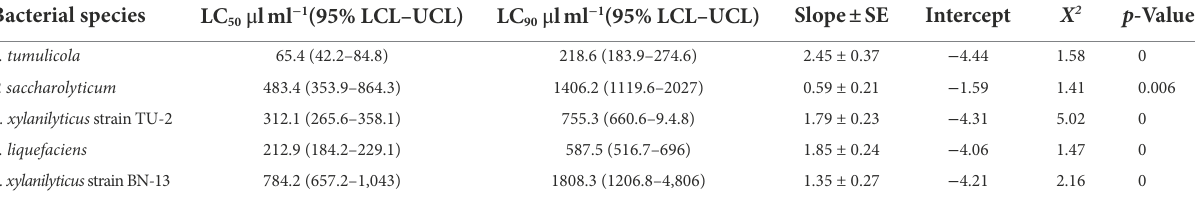
* Each figure represented as a power of 10. LC 50 , lethal concentration that kills 50% of insects; LC 90 , lethal concentration that kills 90% of insects; LCL, lower confidence limit; UCL, upper confidence limit; X 2 , Chi-square value; SE, standard error; and p -value,